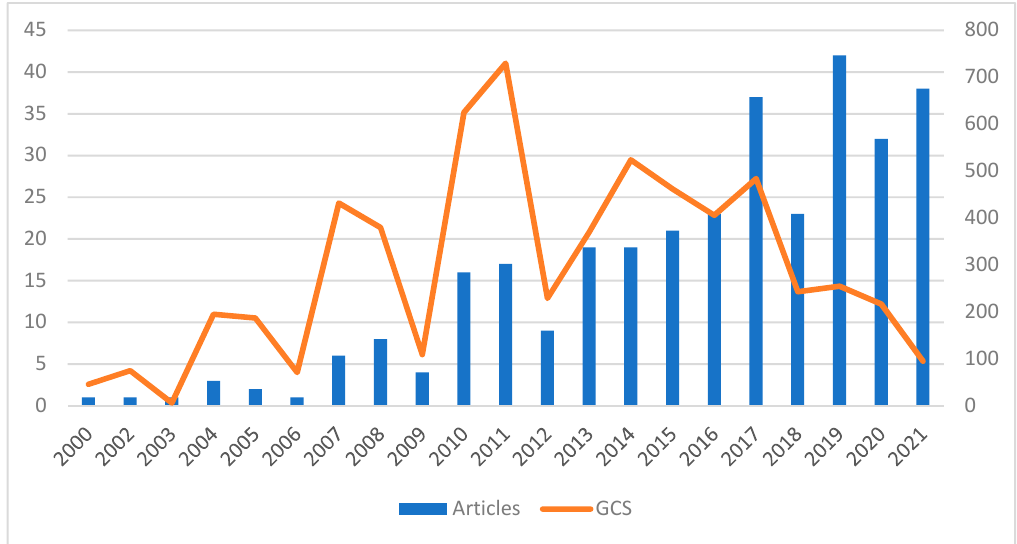
Figure 2. Evolution of the number of articles and reviews published over the years and the number of global citations (2000–2021). GCS = Global Citation Score.